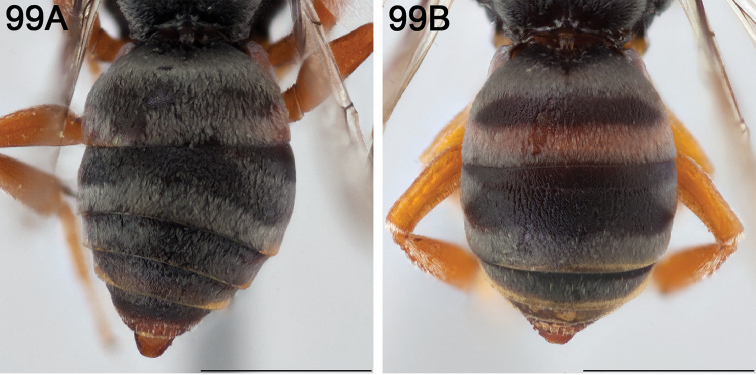
Metasoma (in dorsal view) dampened with water to show differences in integument coloration between T1 of male A
E.
nebulosus paratype, which is entirely black, and B
E.
novomexicanus, which is red beneath the apical fascia. Scale bars 2 mm. Note that lightly wetting the terga with ethanol allows for this feature to be seen without having to remove the tomentum.